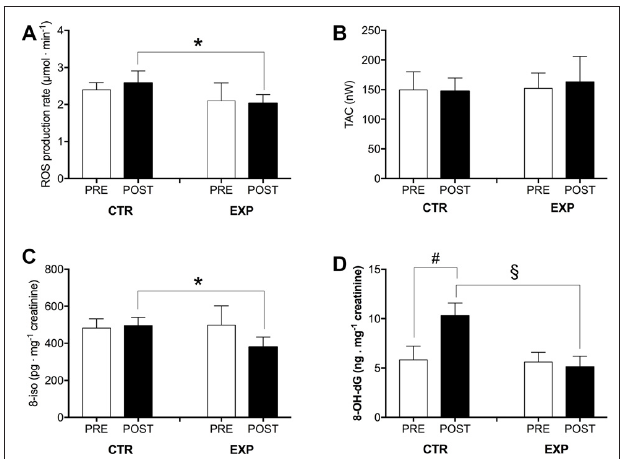
FIGURE 3 | The influence of physical and cognitive training on oxidative stress (OxS) is shown by the histogram plots of: (A) reactive oxygen species (ROS) production rate ( µ mol · min − 1 ), (B) total antioxidant capacity (TAC; nW), (C) lipids peroxidation (8-iso; pg.mg − 1 creatinine) and (D) DNA damage (8-OH-dG; ng.mg − 1 creatinine) obtained from capillary blood and urine samples in the control (CTR) and experimental (EXP) groups at PRE and POST (after 6 weeks). Results are expressed as mean ± SD. Statistically significant differences symbols: ∗ p < 0.05, # p < 0.01, and § p <